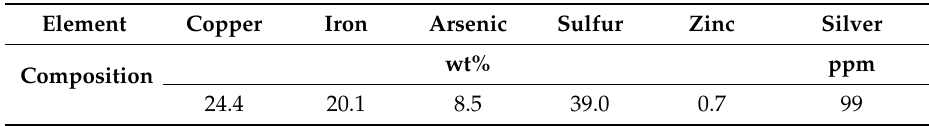
Table 1. Head assay of enargite